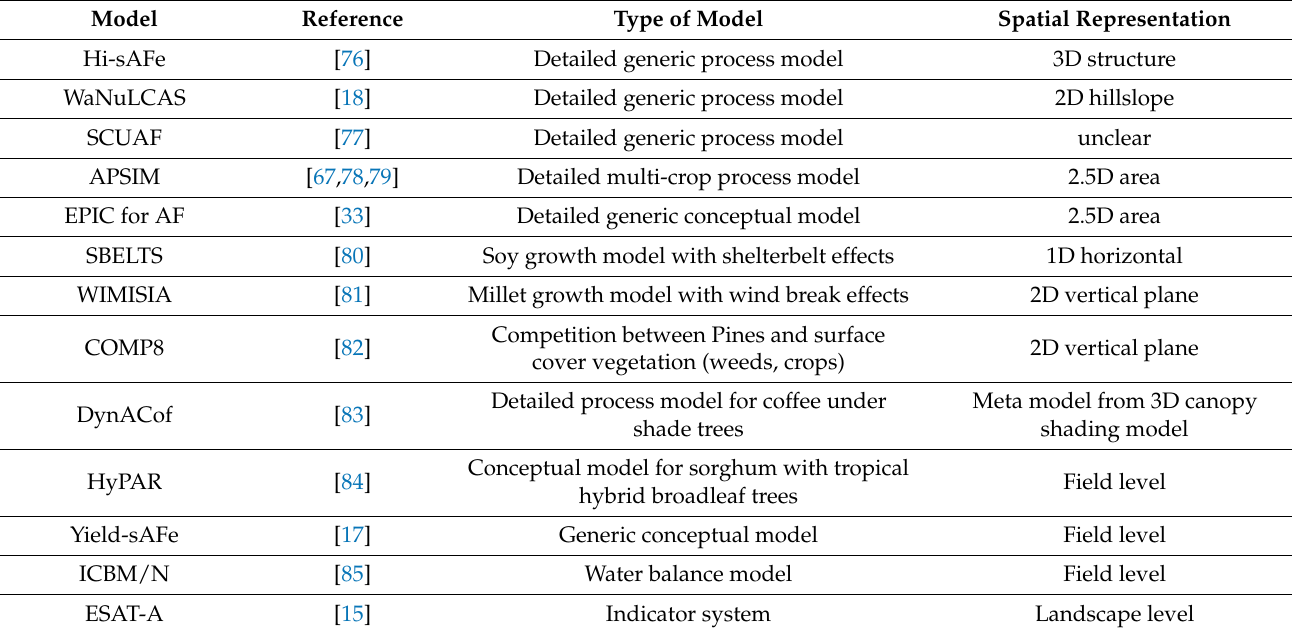
Table 2. Agroforestry models considered in this